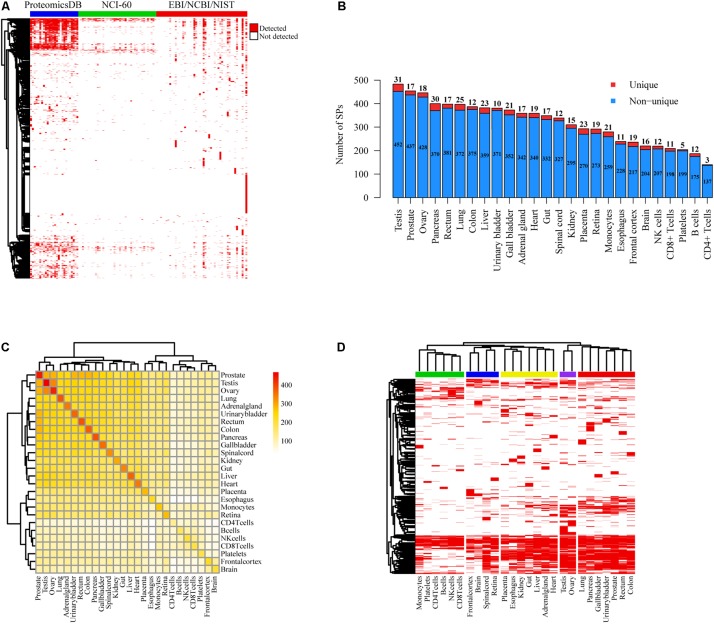
Protein level evidences of SPs supported by MS data. (A) Heatmap of SP presence in different tissues and/or cell lines based on the MS data of ProteomicsDB, NCI-60 cell lines, and EBI/NCBI/NIST database. Red represents the presence of SP, whereas white represents not. (B) Number distribution of detected SPs in distinct tissues and cells of ProteomicsDB project. The counts of unique and non-unique SPs were shown respectively. (C) Heatmap of shared SPs between each two different tissues or cells of ProteomicsDB project. (D) Clustering of different tissues and cells of ProteomicsDB project based on SP presence. Red stands for the presence of SP, whereas white represents not.